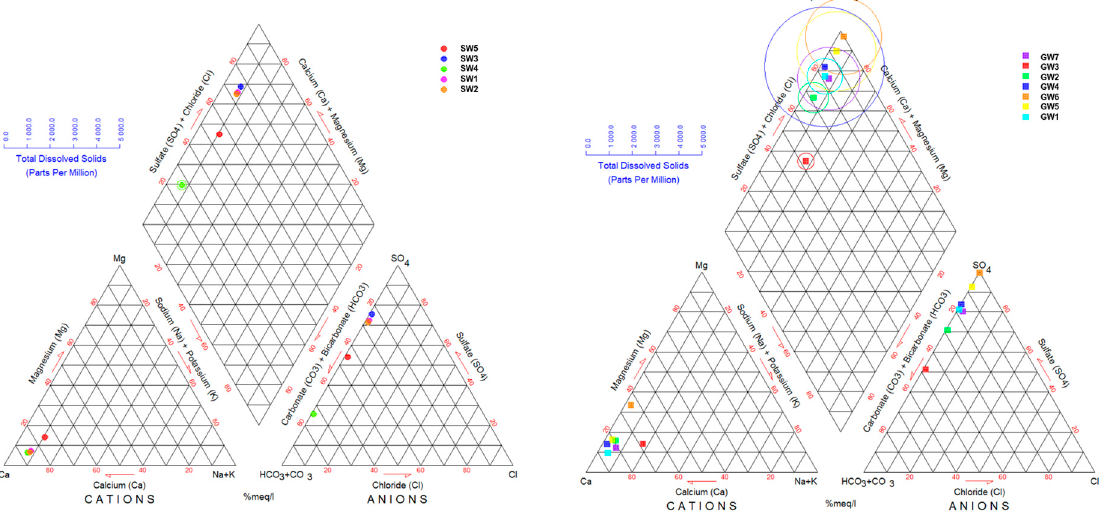
Figure 12. Piper diagram for the chemical composition of surface and groundwater samples.